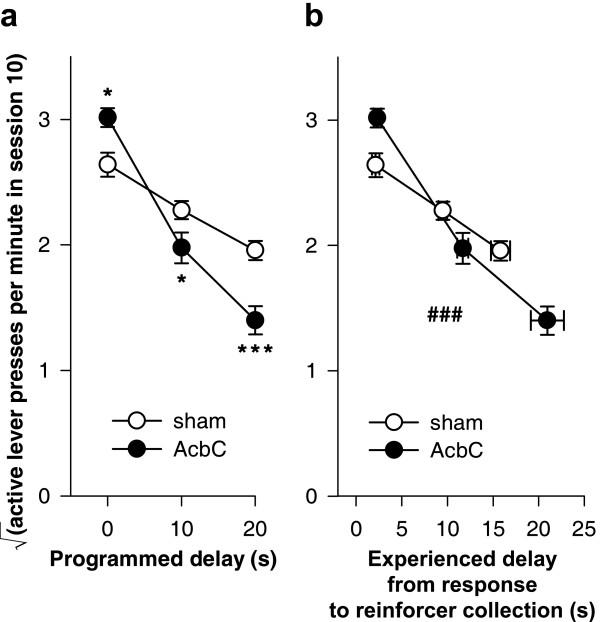
Learning as a function of programmed and experienced delays to reinforcement The imposition of response-reinforcer delays systematically retarded the acquisition of free-operant instrumental responding, and this relationship was altered in AcbC-lesioned rats, even allowing for differences in experienced response-collection delays. (a) The rate of responding on the active lever in session 10 is plotted against the programmed response-reinforcer delay. AcbC-lesioned rats responded more than shams at zero delay (* p = .013), but less than shams at 10 s (* p = .049) and 20 s delay (*** p = .001). (b) Responding on the active lever in session 10 plotted against the experienced response-to-reinforcer collection delays for sessions 1–10 (vertical error bars: SEM of the square-root-transformed number of responses in session 10; horizontal error bars: SEM of the experienced response-collection delay, calculated up to and including that session). The gradients of the two lines differed significantly (### p = .001; see text), indicating that the relationship between experienced delays and responding was altered in AcbC-lesioned rats.